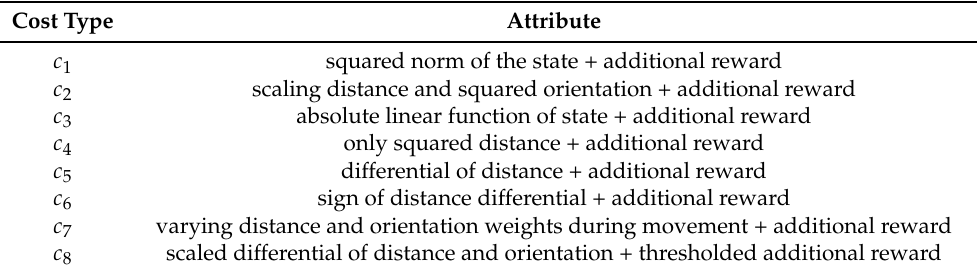
Table 1. Summary of the costs